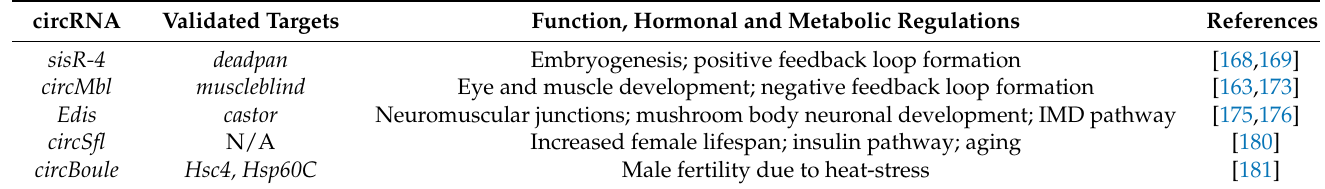
Table 3. Summarisation of circRNAs reported with their validated targets, function, and hormonal and metabolic regulations according to their